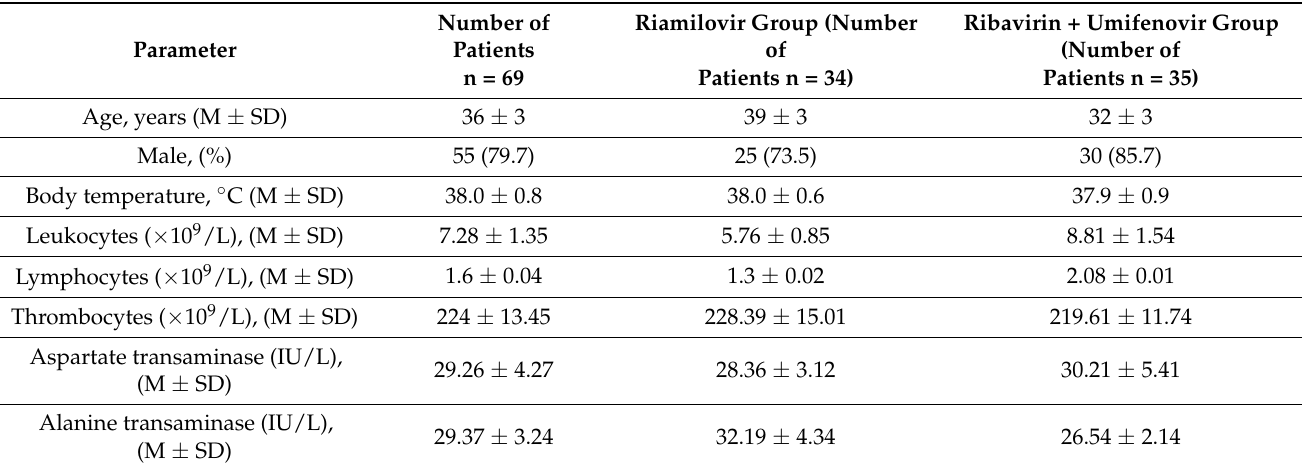
Table 2. Some characteristics of patients involved in the clinical trials. Reprinted/adapted with